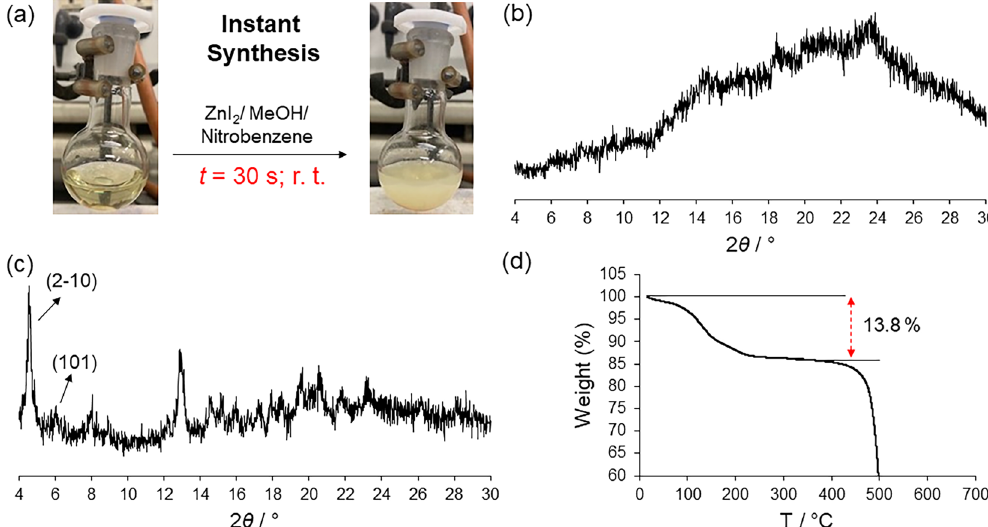
Figure 2. ( a ) Pictures taken during the instant synthesis experiments in the preparation of the TPB -ZnI 2 poly-[ n ]-catenane at room temperature conditions before adding ZnI 2 (left) and after complexation (right). ( b ) Experimental powder XRD pattern of the solid product ( a1 ) obtained from the instant synthesis of TPB and ZnI 2 using nitrobenzene as the templating aromatic solvent. The diffraction pattern shows that the material is amorphous. ( c ) The peak intensities observed in the powder XRD denote the formation of a crystalline phase. The first two peaks with Miller indices of (2–10) and (101) are highlighted. ( d ) TGA data carried out on a1 immersed in MeOH/toluene showing the weight loss corresponding to ca . 14% of the total